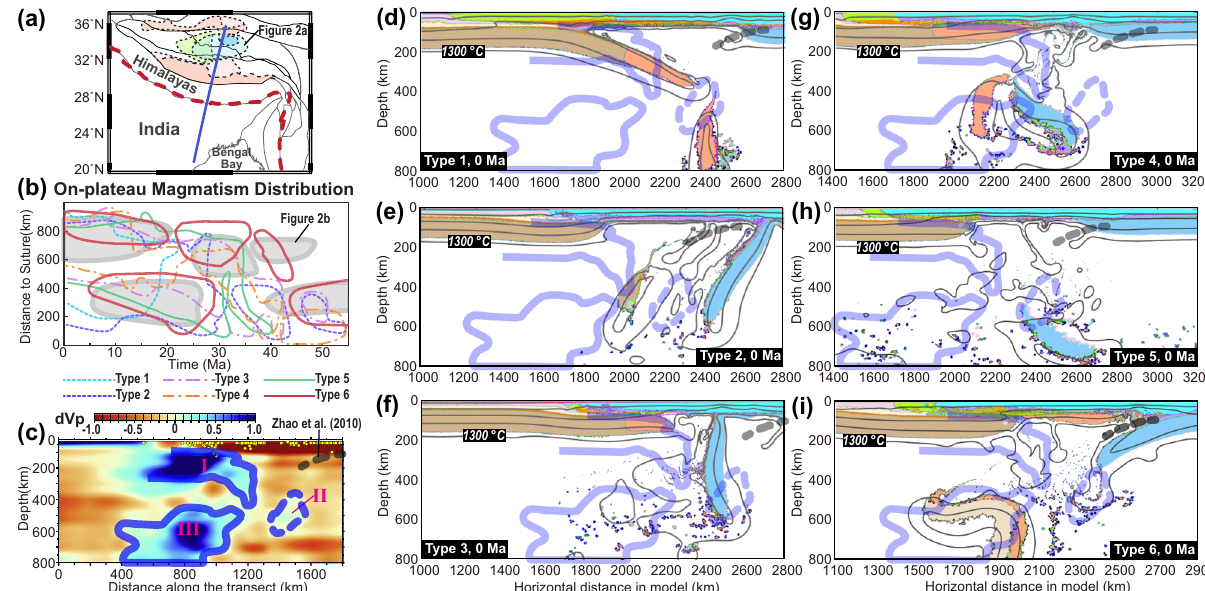
Fig. 9 | Comparisons between model results and geological and geophysical observations.a ThedistributionofmagmatismontheTibetanPlateau(Fig.2a)and the transect location (blue line) for the seismic tomography result in Panel c . b Magmatic history in Type 1 (Run 3), Type 2 (Run 6), Type 3 (Run 9), Type 4 (Run 13), Type 5 (Run 18), and Type 6 (Run 23) models, respectively. Background shad- ings illustrate the time-space range of on-plateau magmatism (see Fig. 2a, b). A moredetailed presentationof thiscomparisonisalsoshowninFig.7. c The P-wave seismic tomography cross-section of the upper mantle beneath North India and